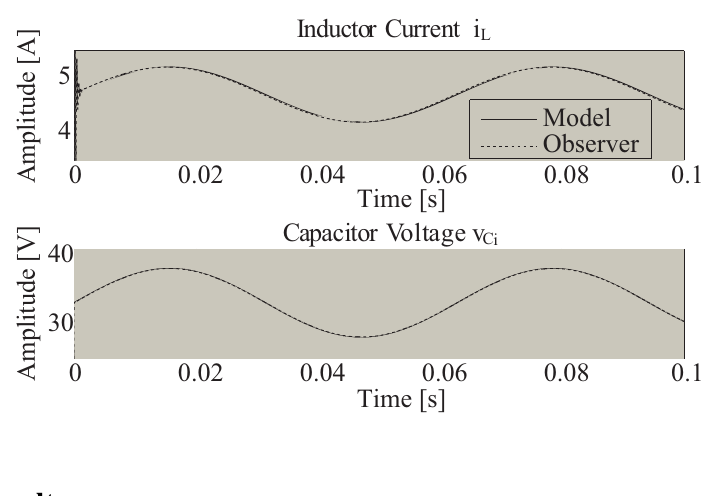
Figure 16. Simulation of the observer designed for L = 56 µ